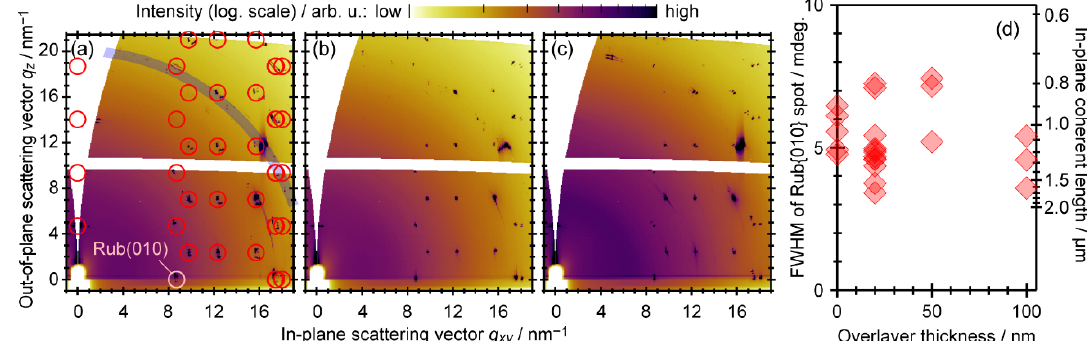
Figure 2. ( a–d ) Two-dimensional grazing incidence X-ray di ff raction (2D-GIXD) images of rubrene single crystal samples ( a ) without and with the homoepitaxially grown rubrene overlayers of ( b ) 50 nm- and ( c ) 100 nm-thick. These images are integrated for the sample azimuthal angle over 180 ◦ (900 images taken for every 0.2 ◦ ). Expected positions for the di ff raction spots from the (100) surface of rubrene single crystal and Si (powder) are indicated with circle marks and a thick arc, respectively, on ( a ). ( d ) Full-width at half-maximum (FWHM) in 2 θ direction of the {010} di ff raction spots of rubrene [denoted as Rub{010}] collected by high-resolution grazing-incidence X-ray di ff raction (HR-GIXD) measurements plotted as a function of the rubrene overlayer thickness. The corresponding crystallographic coherent length (up to 2 µ m) estimated from the Scherrer equation is also indicated in the right axis for reference.